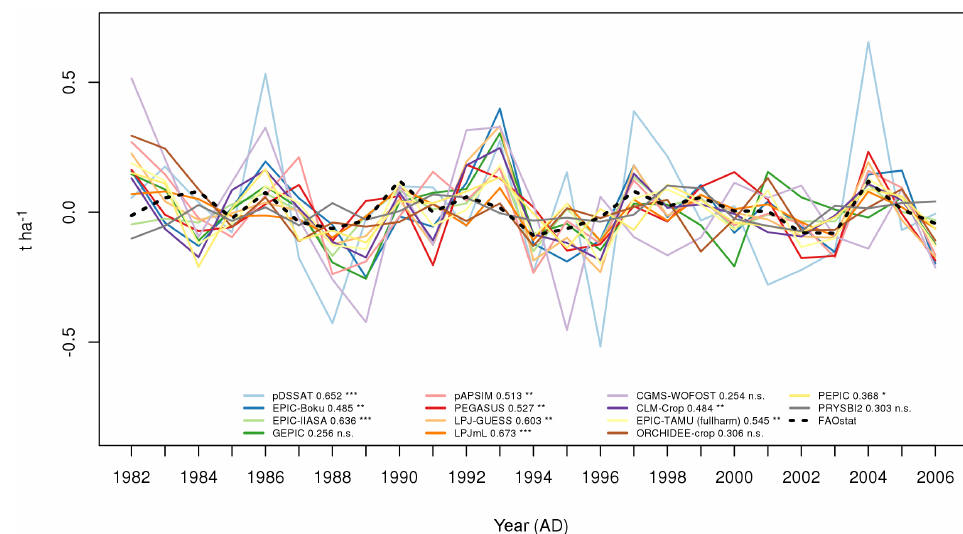
Figure 2. As Fig. 1 but for